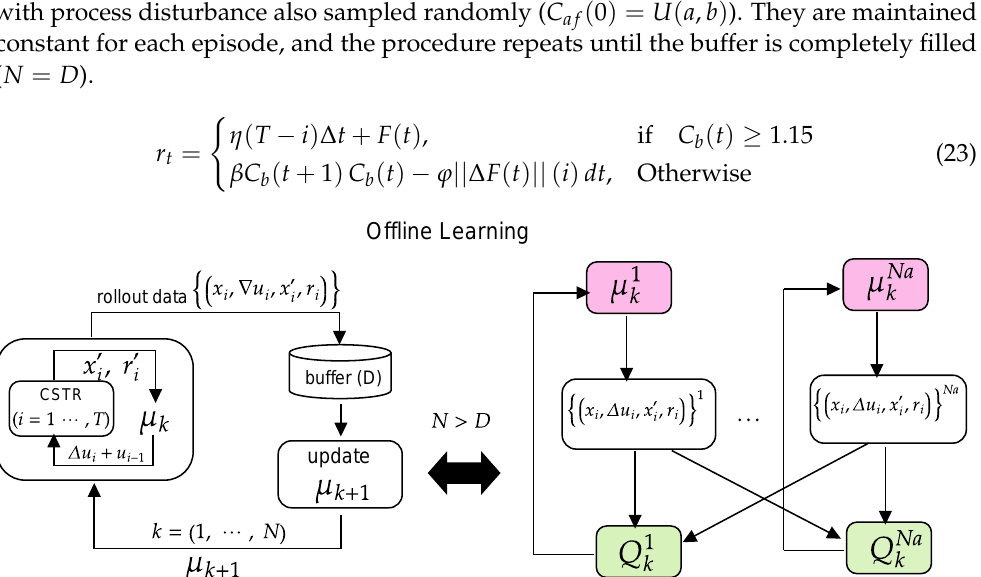
Figure 7. Offline learning with multi-agent deep deterministic policy gradient, with a buffer of size D , to optimize and control the Van de Vusse